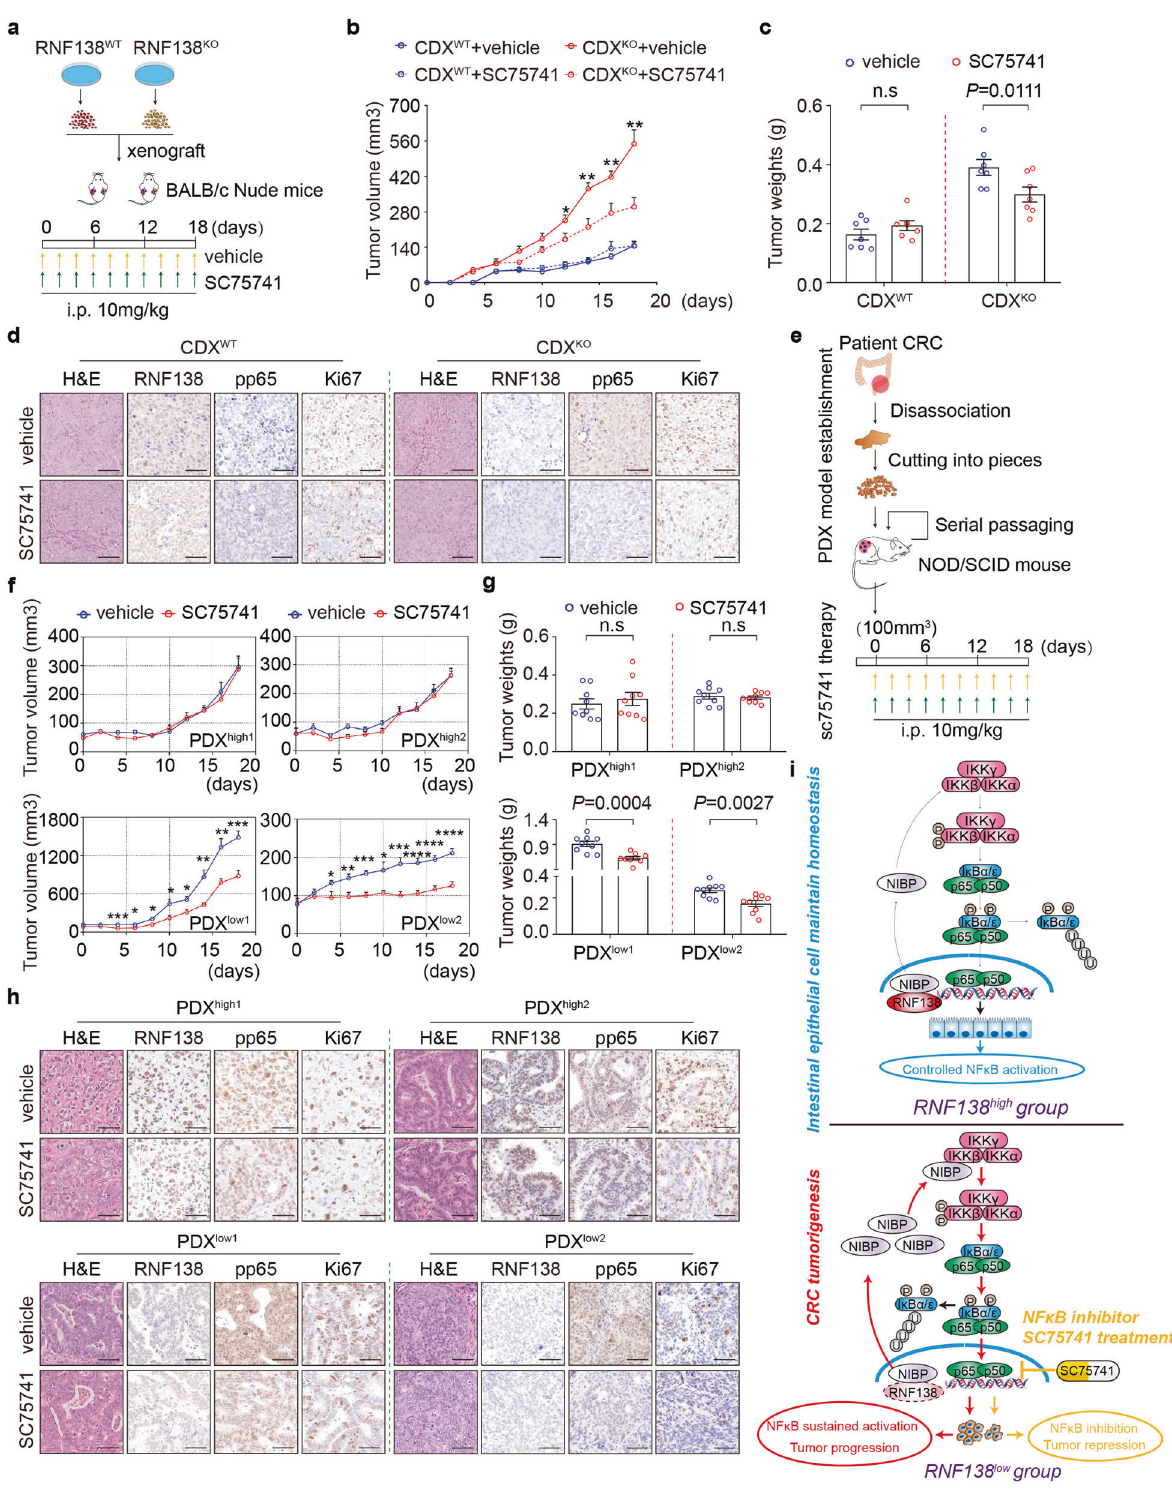
Fig. 7 Targeting NF- к B signaling suppresses the RNF138-ablated CRC tumor growth. a Schematic overview of HCT116 CDX model establishment and SC75741 treatment. b The tumor growth curve of CDX model in RNF138 WT and RNF138 KO HCT116 cells treated with vehicle or SC75741 for 18 days n = 7. c Quanti fi cation of tumor weights from CDX model 18 days post-implantation ( n = 7). d Representative H&E and IHC-staining of RNF138, pp65, and Ki67 from nude mice tumors. Scale bar, 25 μ m. e Schematic overview of PDX model establishment and SC75741 treatment. f Tumor growth curve of PDX model of RNF138 high -pp65 N/C ratio low and RNF138 low -pp65 N/C ratio high treated with vehicle or SC75741 for 18 days ( n = 9). g Quanti fi cation of tumor weights from PDX models on the 18th day post-injection SC75741 ( n = 9). h Representative H&E and IHC-staining with anti-RNF138, -pp65, and -Ki67 antibodies in tumor tissue from PDX models. Scale bar, 25 μ m. i Proposed model for the role of NF- κ B signaling regulated by RNF138 in colonic neoplastic transformation, progression, and SC75741 treatment Signal Transduction and Targeted Therapy (2022)